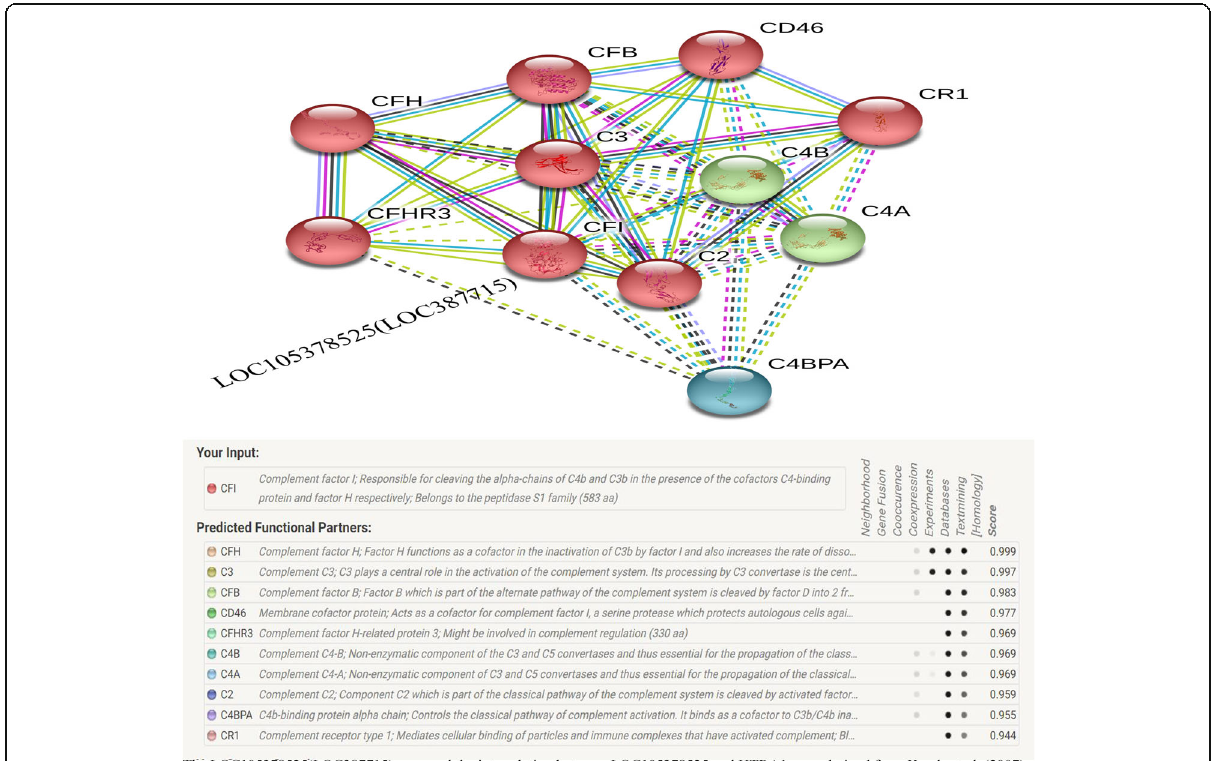
Fig. 8 Interactions network about human HTRA1 gene and other related genes from String server. ACAN: aggrecan core protein; ARMS2: age- related maculopathy susceptibility; CLPP: ATP-dependent Clp protease proteolytic subunit; CTRC: chymotrypsin-C; YME1L1: ATP-dependent zine metalloprotease YME1L1; CFH: complement factor H; HSPD1: 60 kDa heat shock protein; RPL34: 60S ribosomal protein L34; CLPX: ATP-dependent Clp protease ATP-binding subunit clpX-like; PLEKHG4: